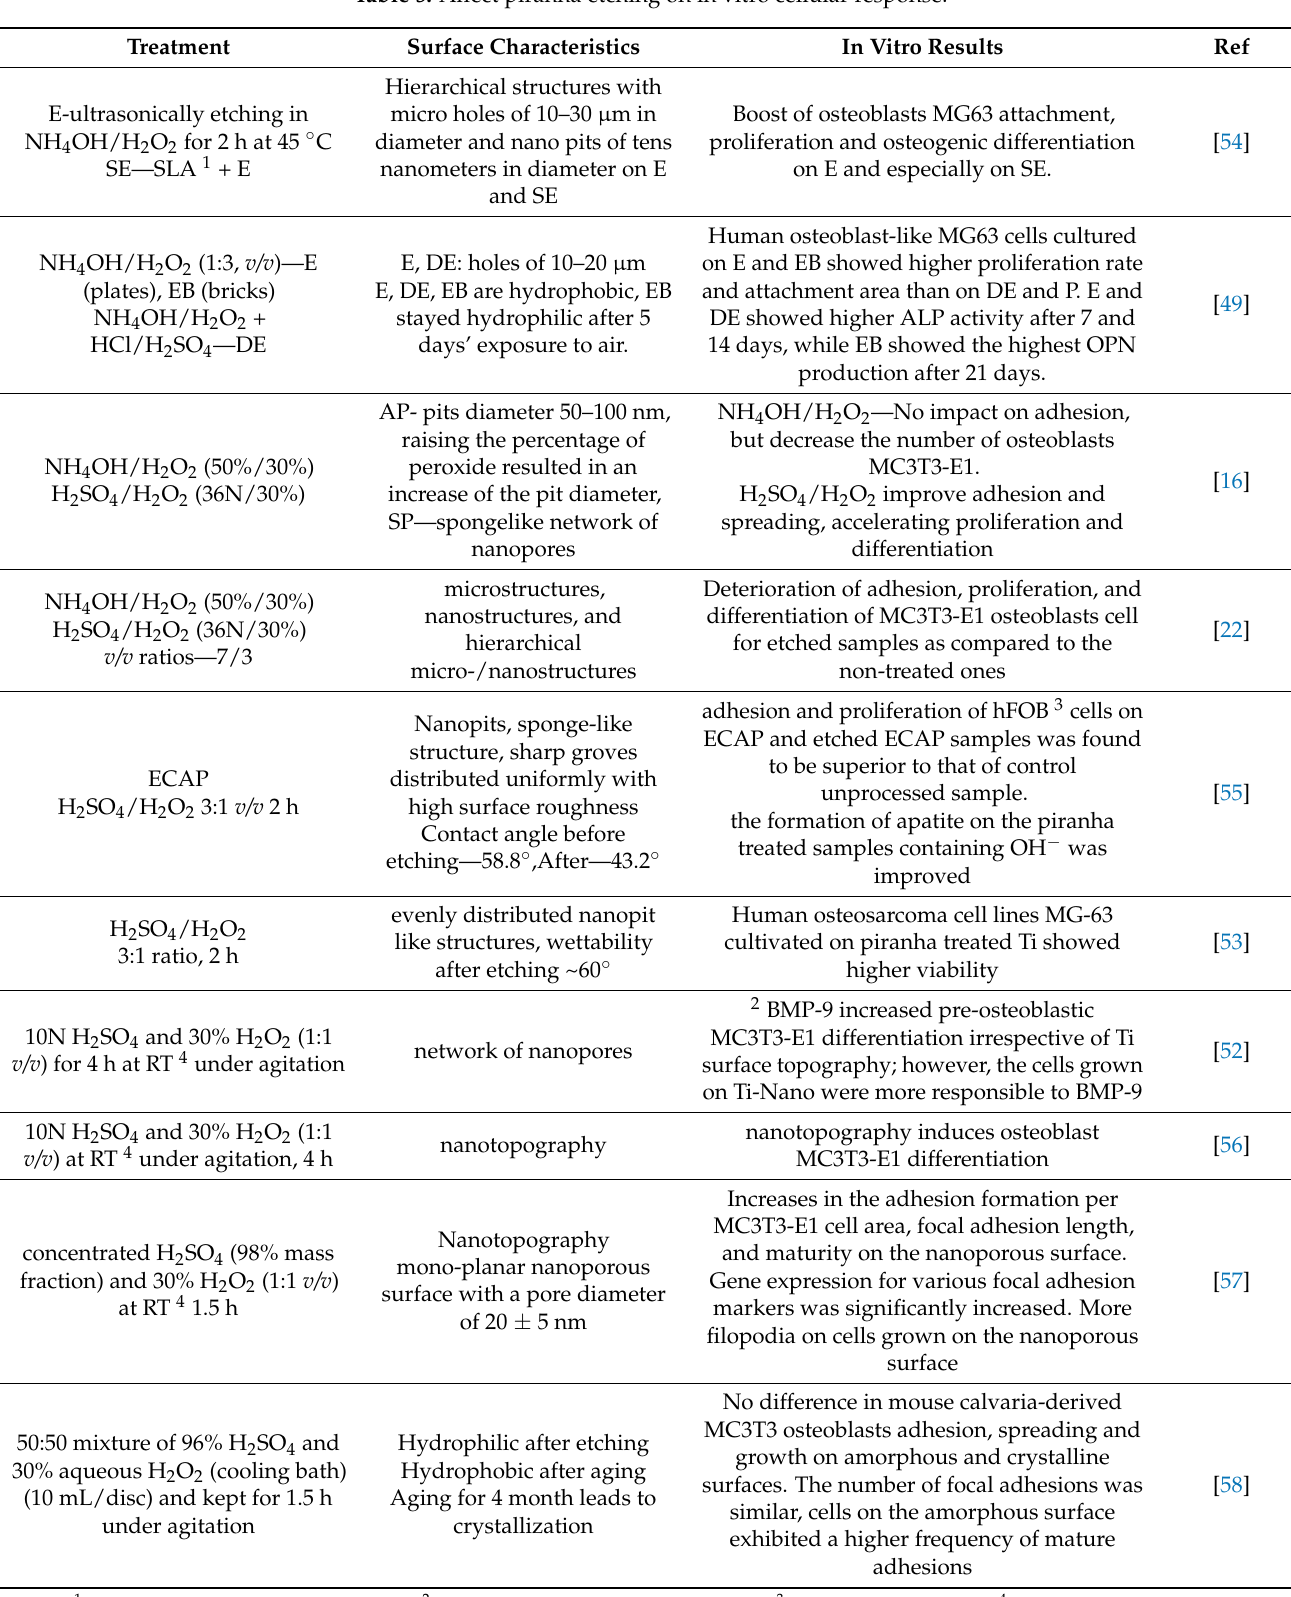
Table 5. Affect piranha etching on in vitro cellular